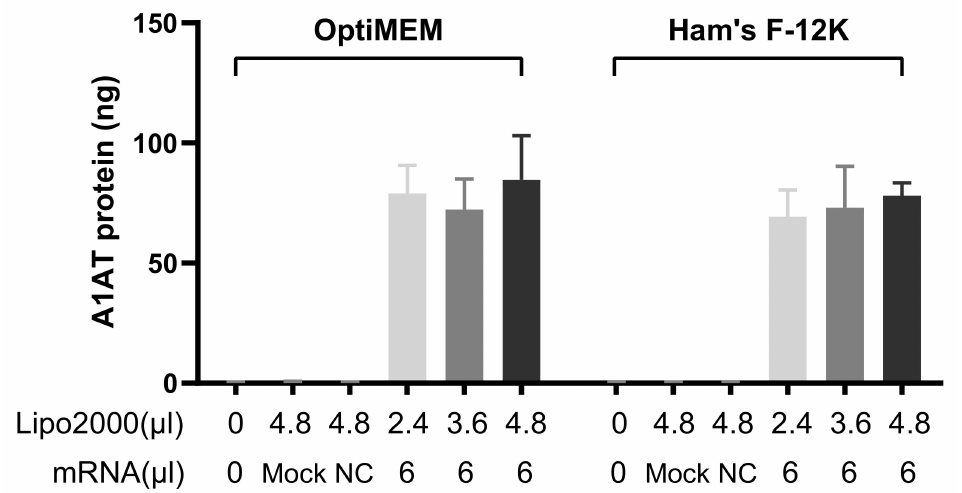
Figure 5. Transfection efficiency mediated by A1AT-mRNA/Lipofectamine2000 complexes. Detected amounts of secreted A1AT after transfection with IVT-mRNA/Lipofectamine2000 complexes using an ELISA assay. Totals of 2.4 µ L, 3.6 µ L or 4.8 µ L Lipofectamine2000 were mixed with 6 µ L A1AT-mRNA. Untreated samples were used as blank controls, 4.8 µ L Lipofectamine2000-treated samples served as “Mock” controls and lipoplexes prepared by 6 µ L MetLuc-mRNA and 4.8 µ L Lipofectamine2000 were applied as negative controls (“NC”). “Lipo2000” represents Lipofectamine2000 and “mRNA” represents A1AT-mRNA (except Mock and NC). OptiMEM and Ham’s F-12K medium were used to prepare complexes. 16HBE cells were incubated with the complexes for 2 h. To calculate the amounts of produced and secreted A1AT, a standard curve was employed; n =